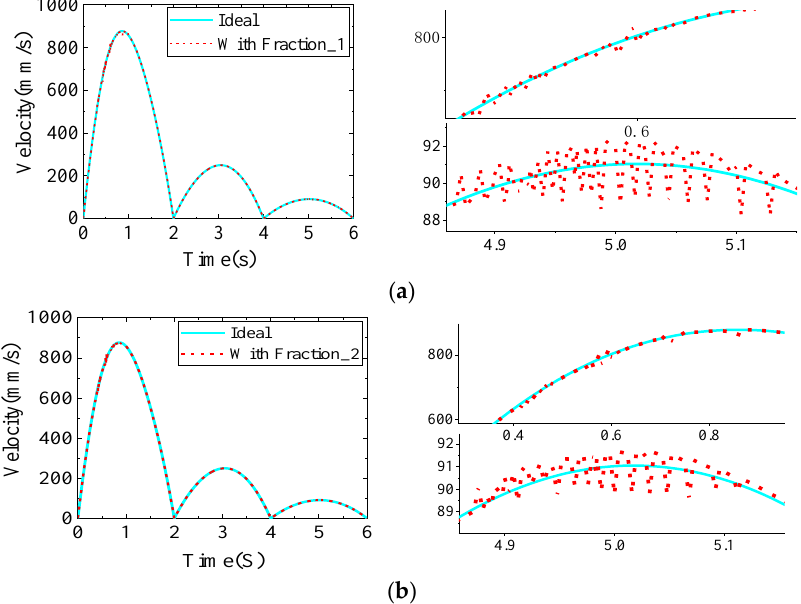
Figure 11. The end velocity change curve when considering friction: ( a ) With Fraction_1; ( b ) With Fraction_2.